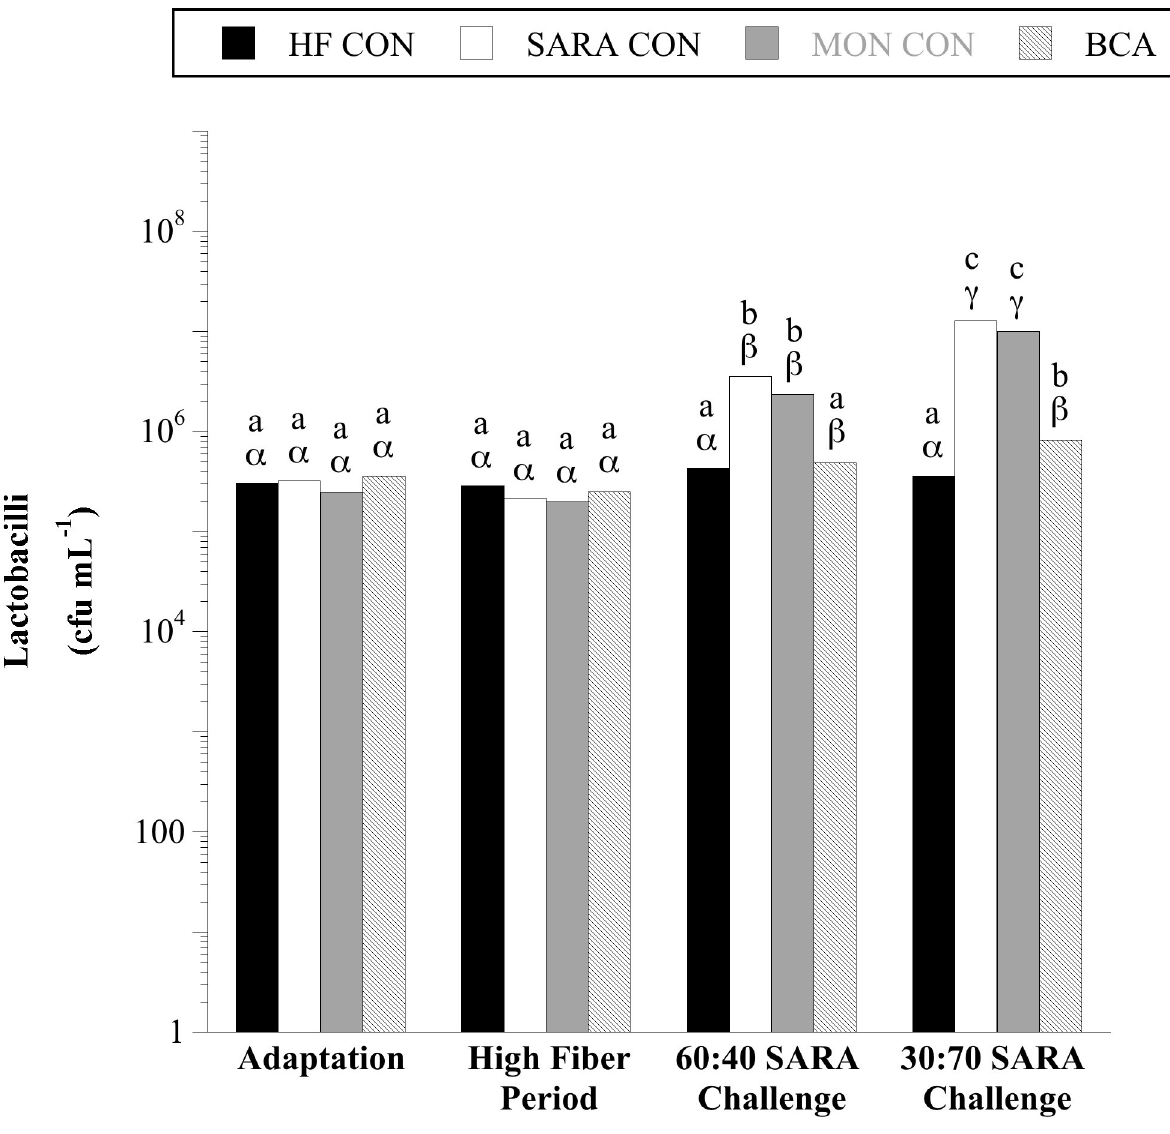
Fig 3. Effect of biochanin A on the viable number of lactobacilli in rumen fluid (4 h post-feeding). Holstein steers (n = 12) were blocked by weight into 1 of 4 treatments: High fiber control (HF CON; basal diet control, corn silage + dried distillers’ grain, to meet protein requirements; n = 3), SARA control (SARA CON; n = 3), SARA + monensin treatment (MON CON; 200 mg d -1 monensin; n = 3), or SARA + biochanin A treatment (BCA; 6 g d -1 biochanin A; n = 3). Rumen fluid samples were taken at the end of the adaptation period (100% basal diet), high fiber period (100% basal diet + treatments), 60:40 SARA challenge period (60% basal diet + 40% cracked corn + treatments), and 30:70 SARA challenge period (30% basal diet + 70% cracked corn + treatments) for lactobacilli bacterial enumeration. The enumerations were performed on Rogosa SL agar (BD). The plates were incubated aerobically (39˚C, 3 d). Plates with 30 < x < 300 colonies were counted. All colonies on Rogosa SL agar were counted as lactobacilli. Means lacking a common English letter are different within sample day ( P < 0.05). Means lacking a common Greek letter are different over sample days within treatment ( P < 0.05). Treatment: P < 0.0001, sample day: P < 0.0001, and treatment × sample day: P < 0.0001; Pooled SEM: Treatment = 0.0352, sample day = 0.0398, treatment × sample day = 0.0796 (log